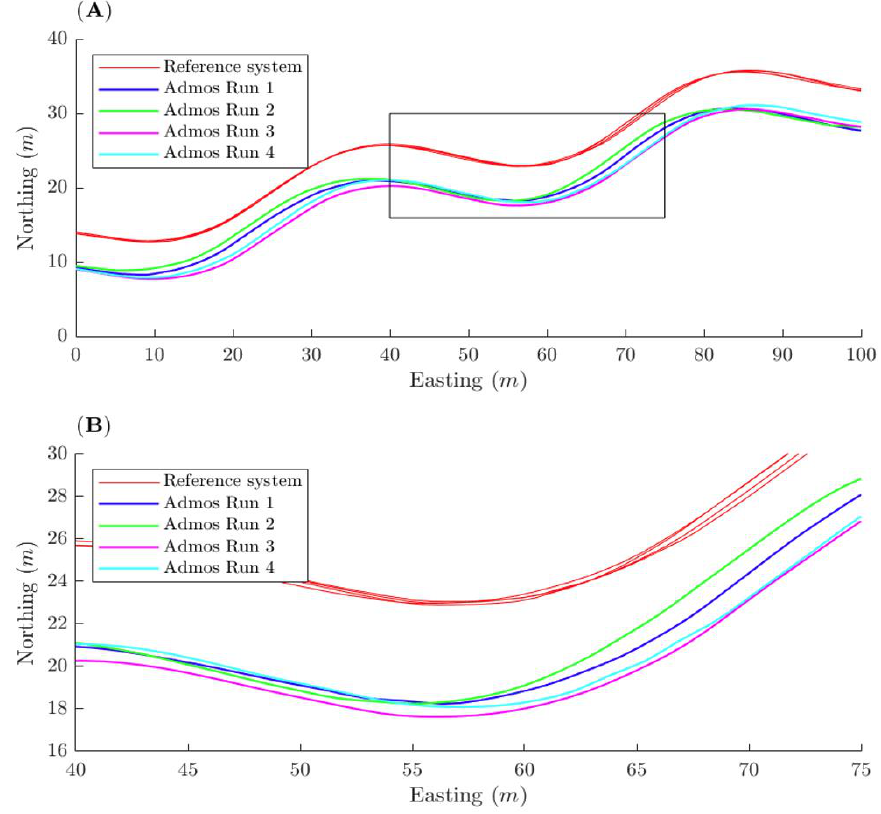
Figure 5. Trajectory measurements with AdMos and the ground truth system for 4 runs over the same course. Ground truth system plotted in red and AdMos plotted in blue, green, magenta and cyan. The coordinates have been made relative for better visualization. ( A ) Trajectory of the last 4 turns of the course. ( B ) Section from A marked with a black box (turn 3).